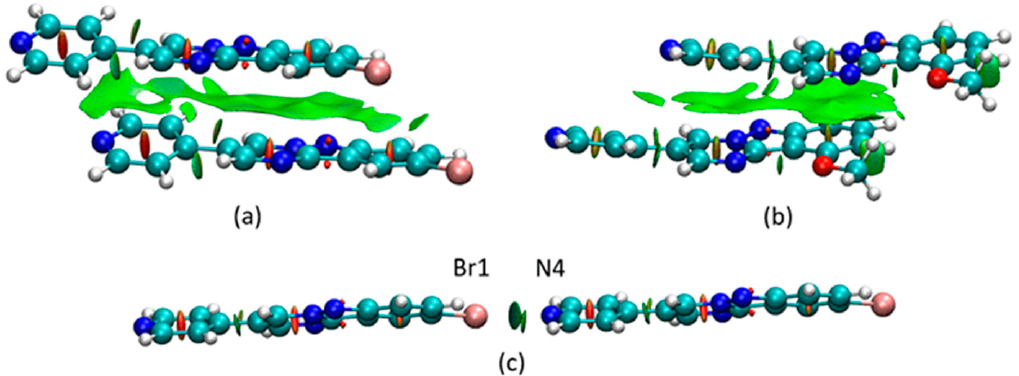
Figure 9. NCI plots (isovalue = 0.5 a.u.) showing the interaction between ( a ) the fused aromatic rings of 1b , ( b ) the fused aromatic rings of 1a and ( c ) Br1 and N4 for 1b .